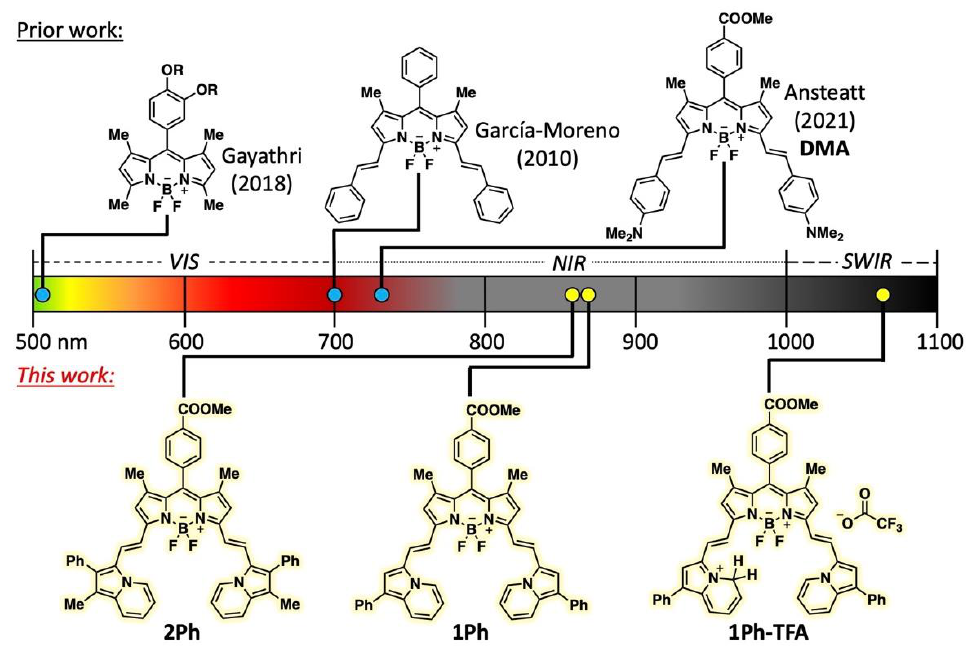
Figure 1. Previously published BODIPY dyes [12,28,29] and novel indolizine-BODIPY dyes orga- nized by peak emission wavelength (λ max emis